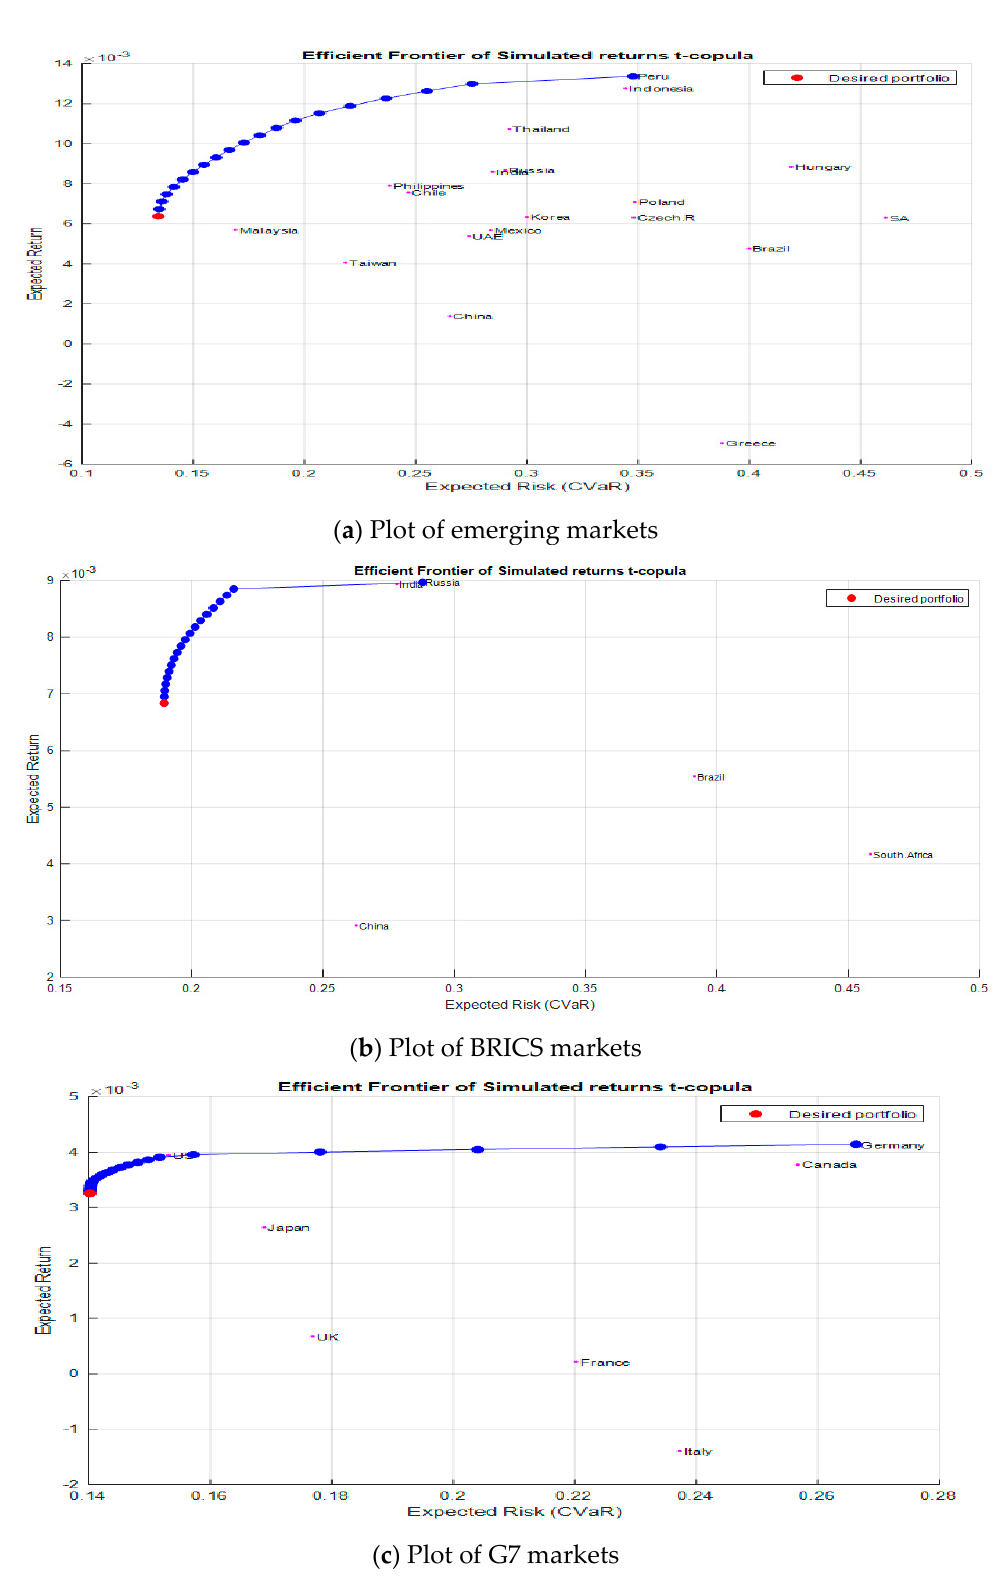
Figure 6. Efficient frontier graphs with copula-simulated returns. Figure 6. E ffi cient frontier graphs with copula-simulated